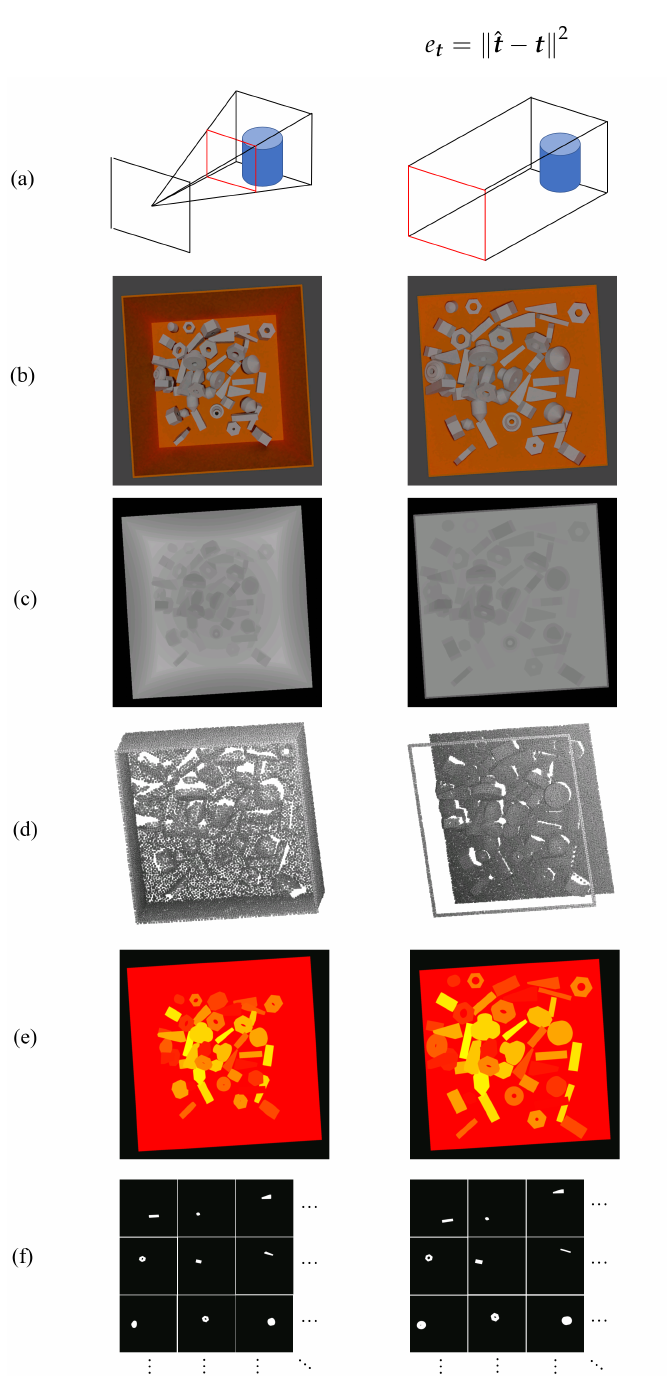
Figure 4. The content of our dataset (Multi-Parametric Dataset). From up to down: ( a ) perspective or orthogonal view, the left column is perspective view, and the right column is orthogonal view; ( b ) RGB image; ( c ) depth image; ( d ) point cloud; ( e ) segmentation image; ( f ) mask images containing individual object only for calculating